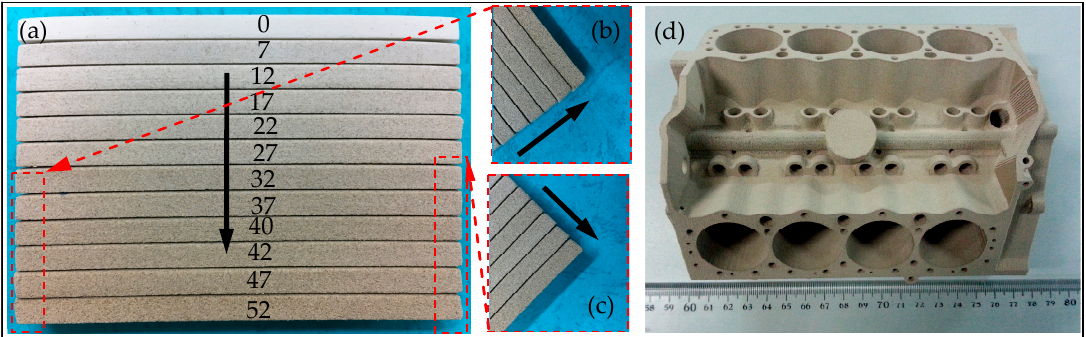
Figure 5. WSPC parts: ( a ) bending parts with different ingredient proportions; ( b ) left defect; ( c ) right defect; and ( d ) demonstration part.